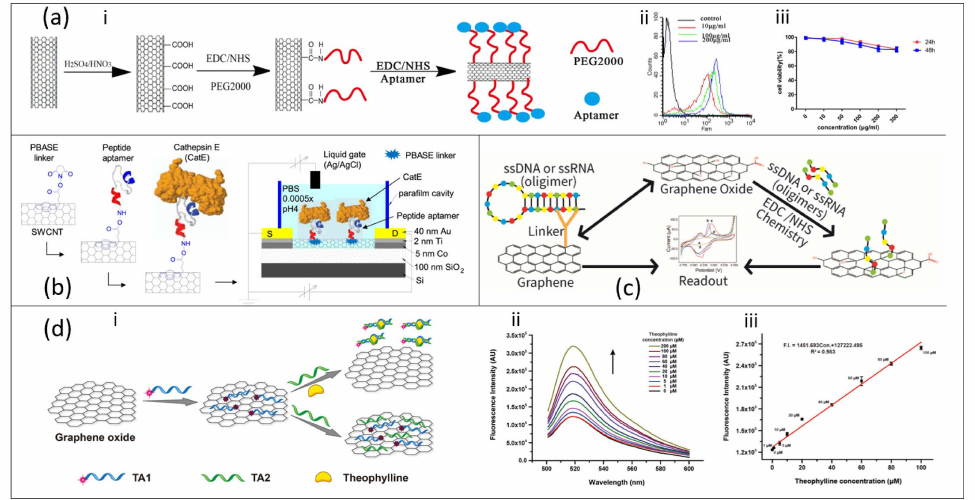
Figure 4. Aptasensors constructed by conjugation of carbon nanotubes (CNTs) with